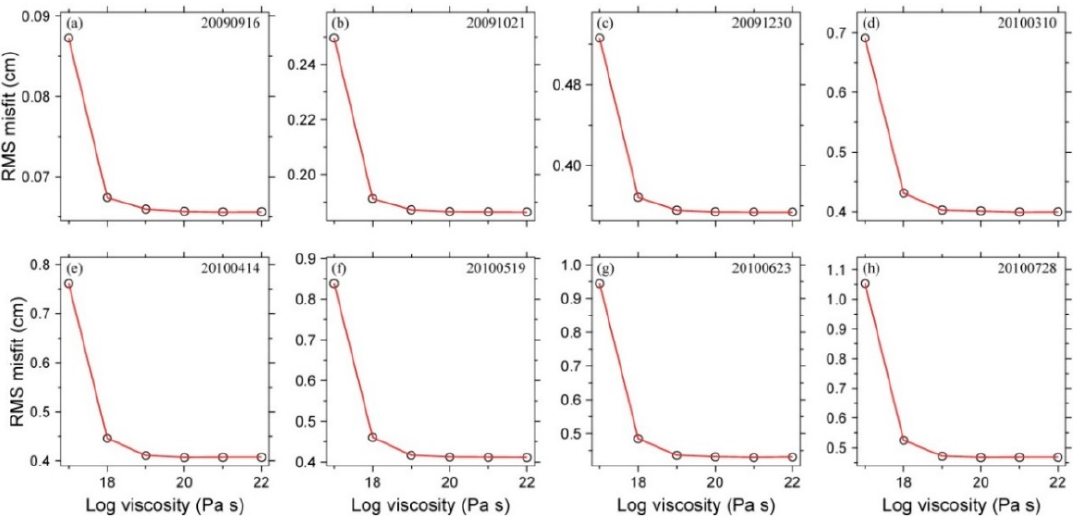
Figure 10. ( a – h ) Relationship curves between the log viscosity and the RMS misfit for the eight time epochs of postseismic deformation observations. For all of the time epochs, beyond the preferred lower bound of the viscosity in Figure 9, the RMS misfits almost no longer change with viscosity. The RMS misfits for the eight postseismic deformation observations are 0.07 cm, 0.19 cm, 0.36 cm, 0.40 cm, 0.41 cm, 0.42 cm, 0.44 cm, and 0.47 cm, respectively. These values are in close agreement with the corresponding standard deviations of the observed deformation (Table 1).